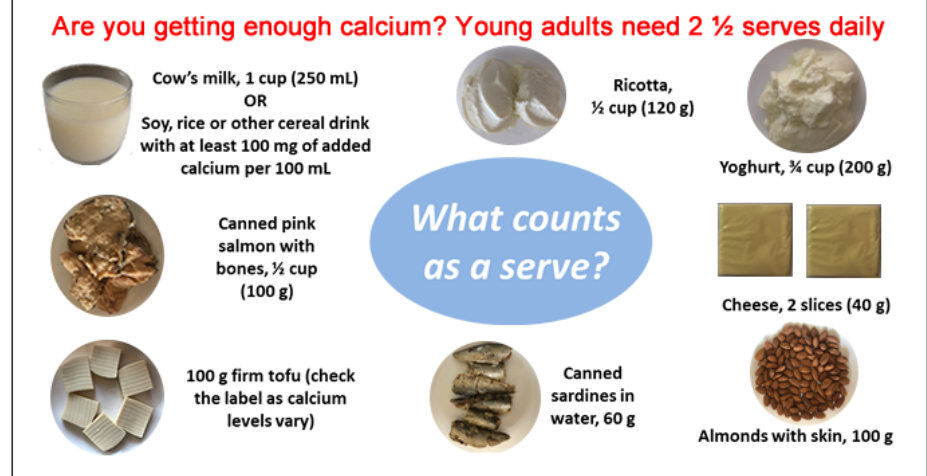
Figure 1. Infographic to inform participants of the